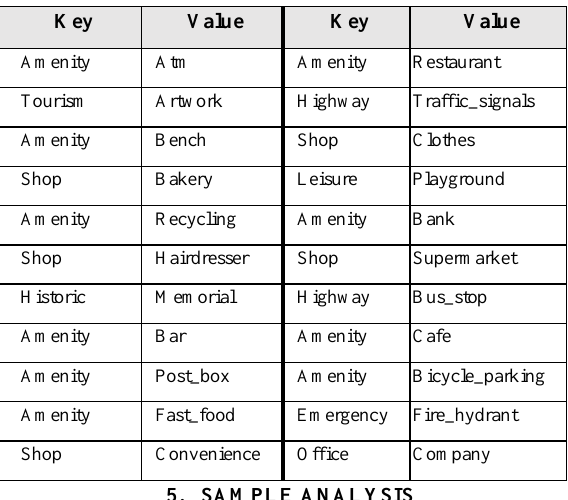
Figure 2. Sample filter to customize the reports in the platform Table 1. List of 22 selected POIs -